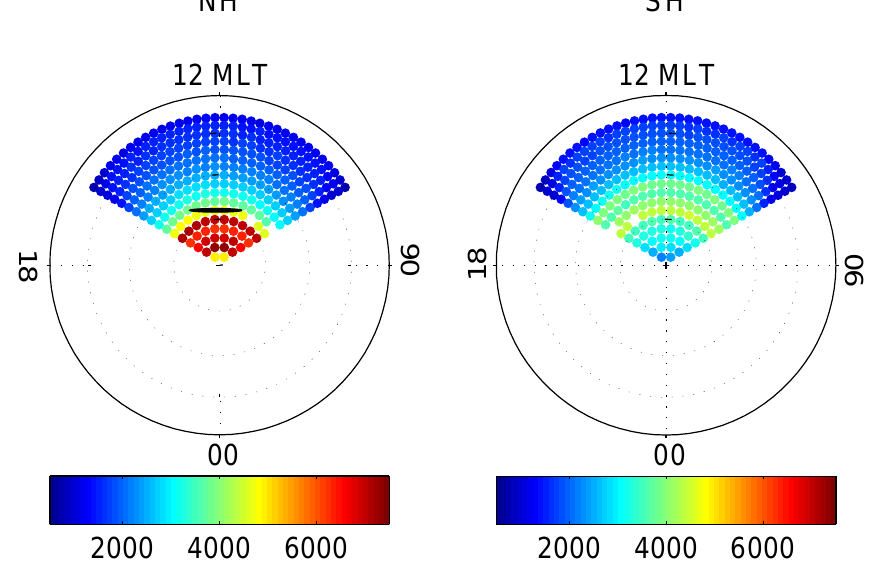
Fig. 2. Sample number per bin, distribution from all CHAMP passes 2002-2005 over the dayside Northern (left) and Southern (right) 6 Hemisphere. The magnetospheric cusp location quoted by Newell and Meng (1992) was inserted in black.